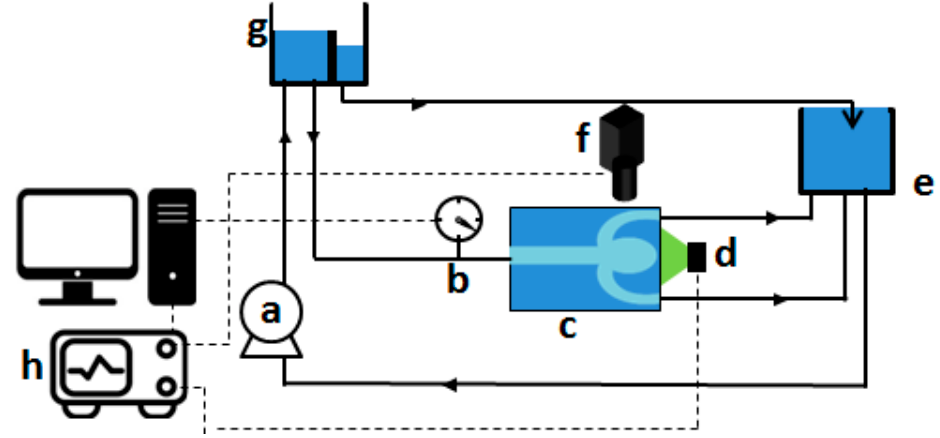
Figure 3. Schematic view of the fluid circuit and PIV setup: ( a ) steady pump, ( b ) magnetic-inductive